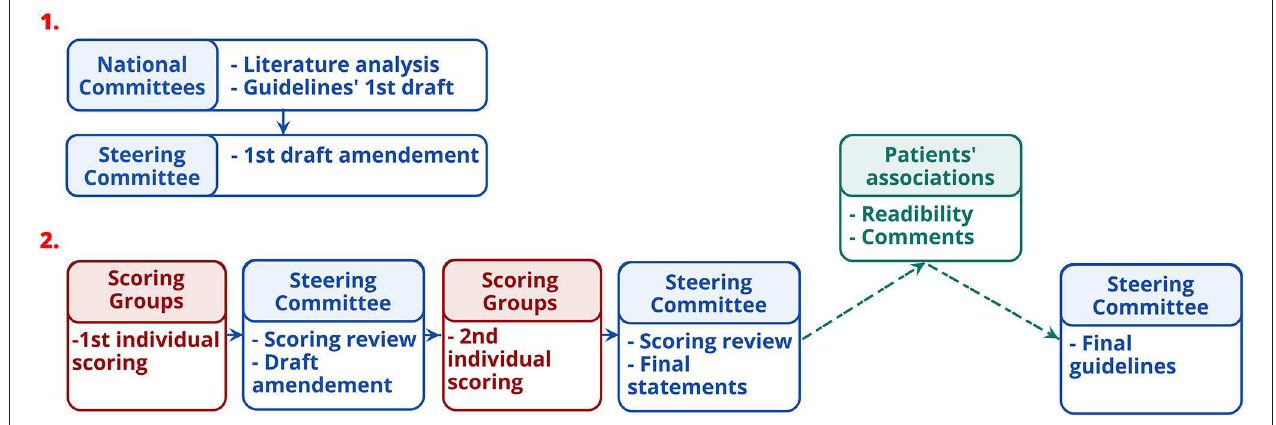
FIGURE 1 | Guidelines’ developing stages.